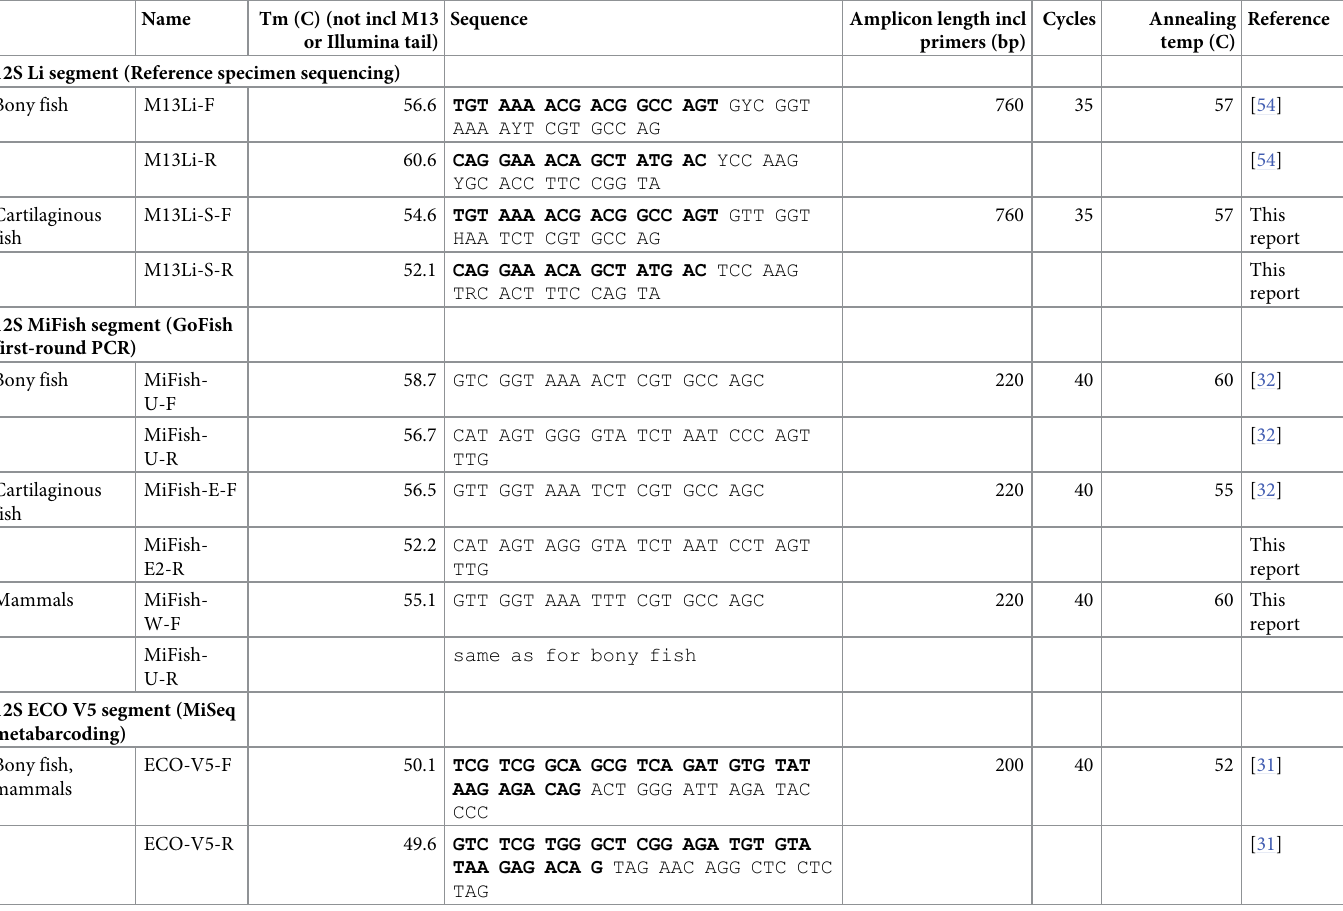
Table 1. Broad-range vertebrate 12S primers. PCR parameters and expected amplicon sizes are shown. M13 and Illumina tails in Li primers and ECO V5 primers, respectively, are highlighted in bold.